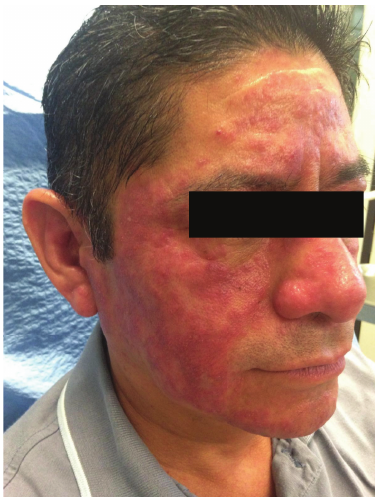
Figure 1: Initial presentation demonstrating indurated, erythema- tous plaques covering most of his forehead, cheeks, nose, and chin.